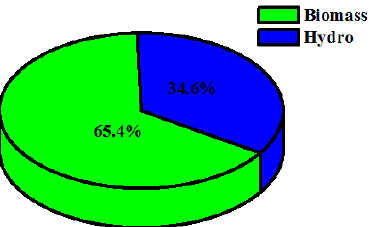
Figure 11. Renewable energy generation percentage for case I (Ba/Bi/H).